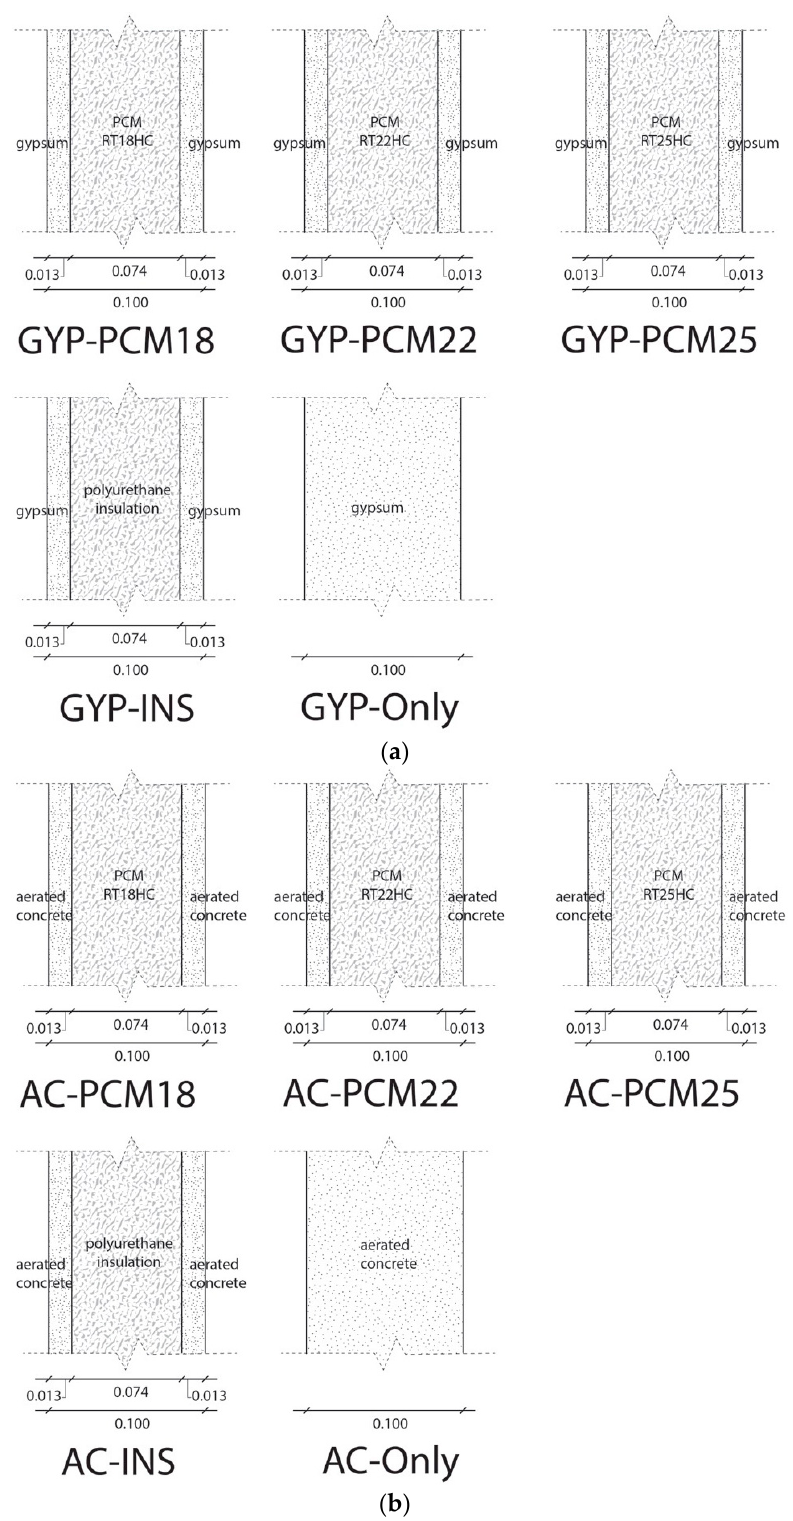
Figure 3. ( a ) Walls and ceiling construction system corresponding to the GYP group of each case scenario. ( b ) Walls and ceiling construction system corresponding to the AC group of each case scenario. All 10 case scenarios representing the envelope construction systems are illustrated in Figure